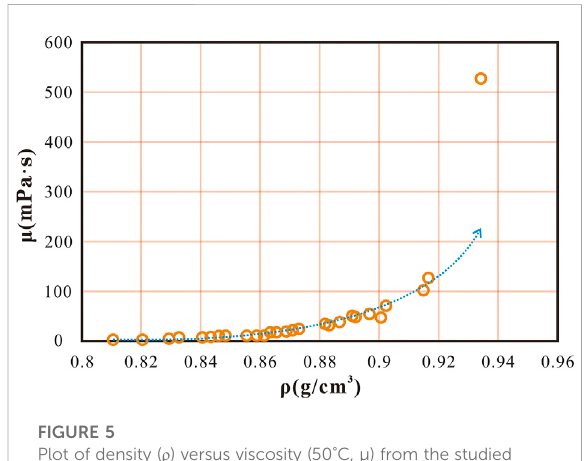
FIGURE 5 Plot of density ( ρ ) versus viscosity (50 ° C, μ ) from the studied Carboniferous crude oil samples in the Hongche fault zone.